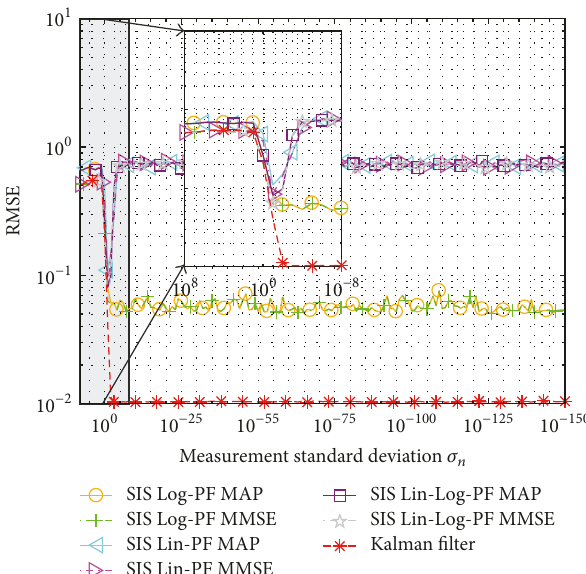
Figure 2: Performance evaluation of the SIS Log-PF, SIS Lin-PF, SIS Lin-Log-PF, and KF by the RMSE versus a decreasing measurement standard deviation 𝜎 𝑛 .